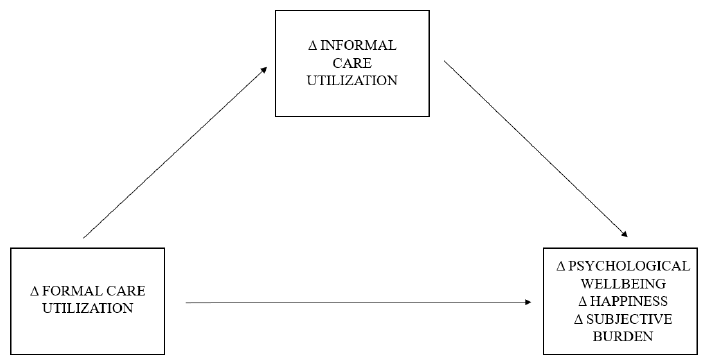
Figure 1. Conceptual diagram of proposed mediation model. Notes: Δ = difference between two time points.